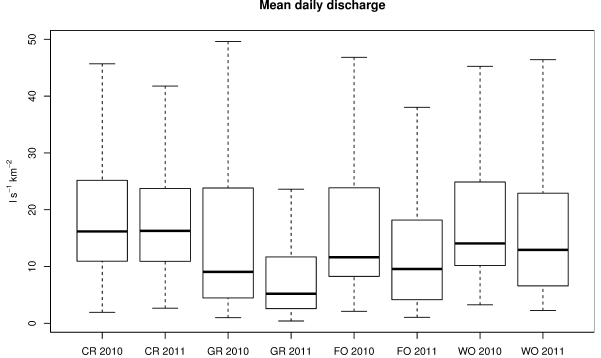
Fig. 2. Box-Whisker plot for the mean daily discharge at the catch- ments outlets (“Crops” – CR, “Grassland” – GR, and “Forest” – FO) and at the “Watershed Outlet” (WO) for hydrological years 2010 and 2011. Whiskers show the lowest value within 1.5 times Interquartile range (IQR) of the lower quartile and highest value within 1.5 times IQR of the upper quartile. Peaks are not